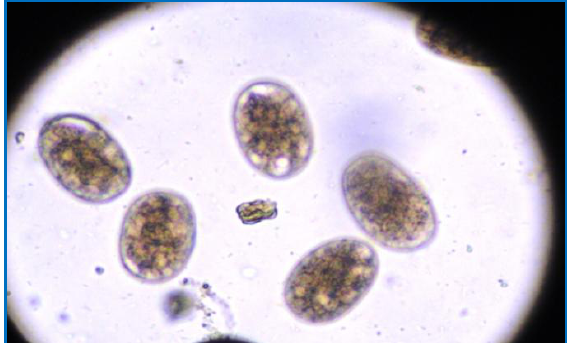
Figure, a: Ancylostoma sp. egg in stray dogs.